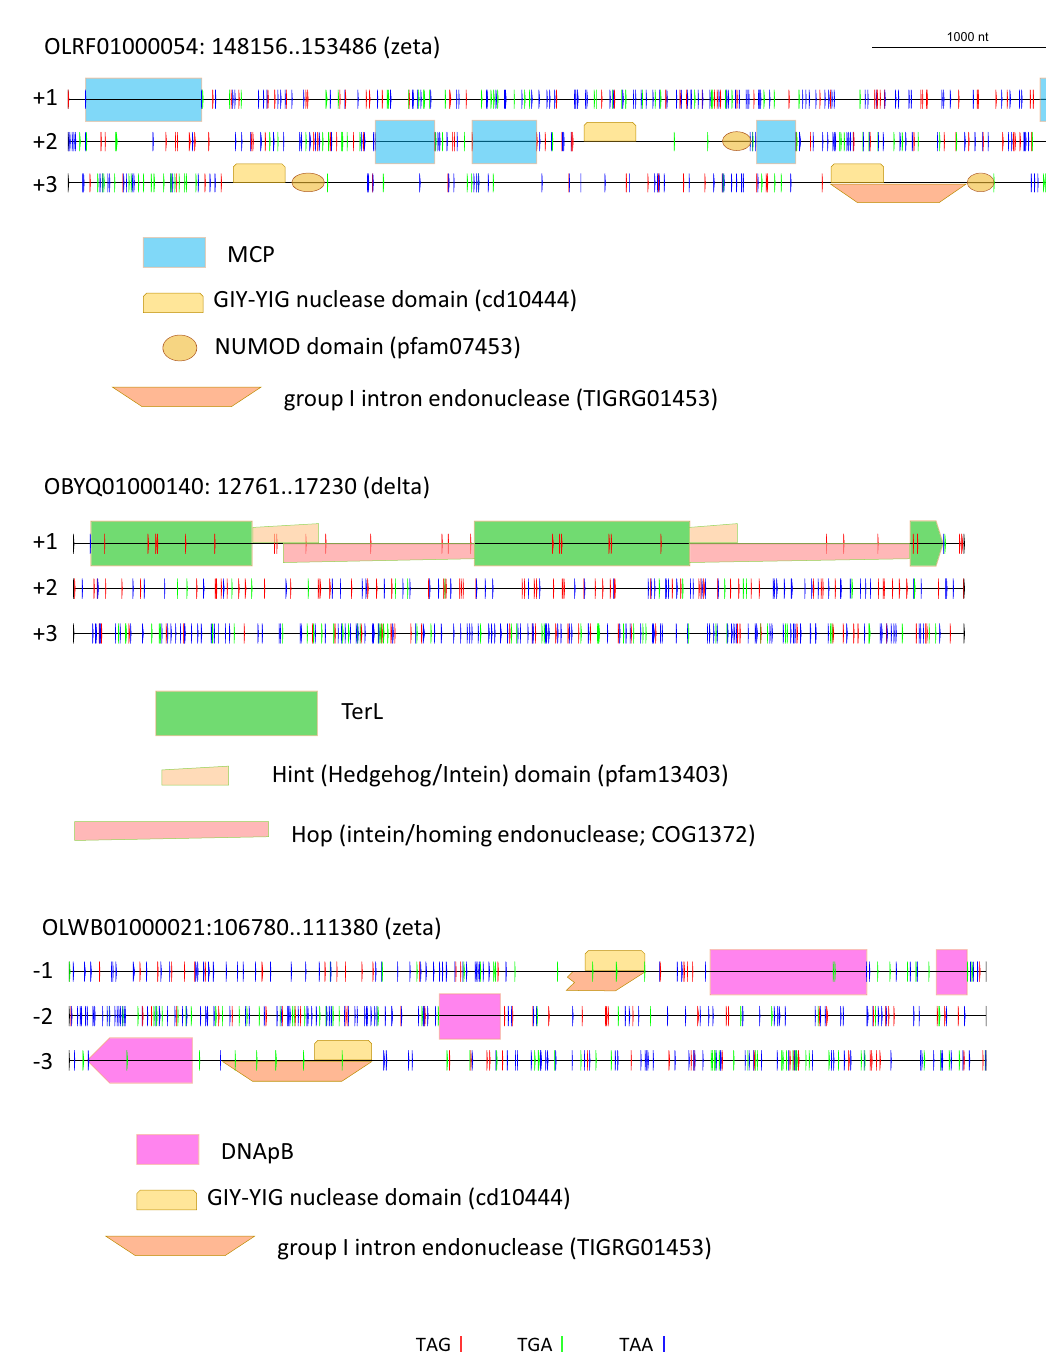
Fig. 7 Examples of stop codon reassignments, intein, and self-splicing intron insertions in conserved genes of crAss-like phages. Horizontal lines denote co-directed reading frames in the nucleotide sequence; short vertical bars indicate standard stop codons (red: TAG, green: TGA, blue: TAA); colored shapes indicate domains or domain fragments, mapped to the nucleotide